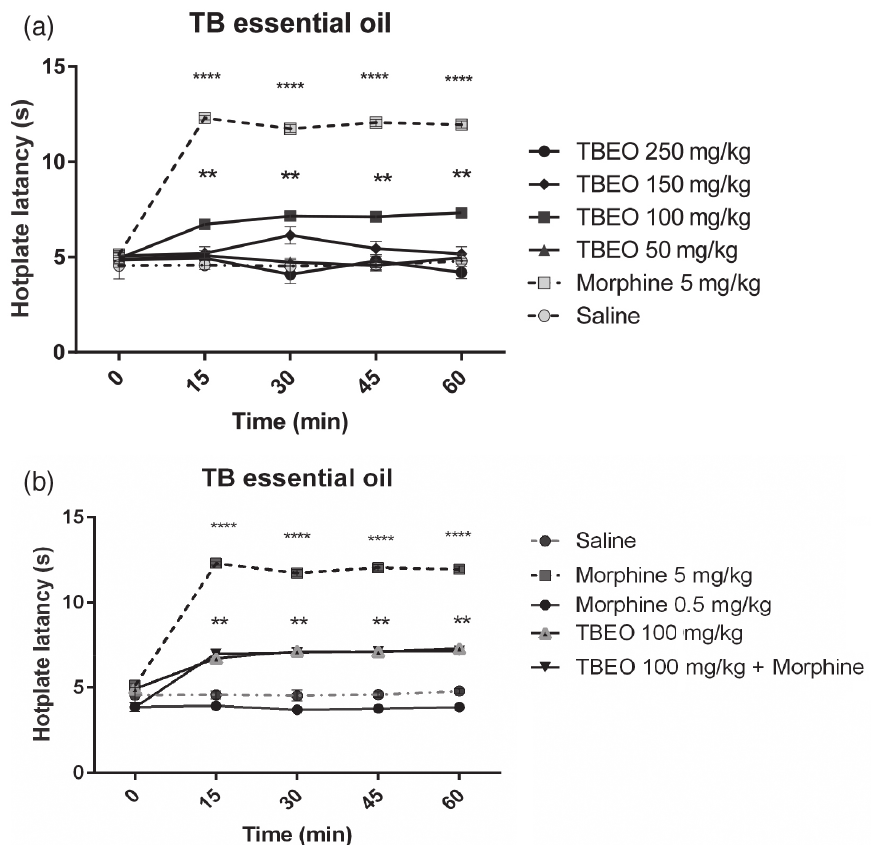
FIGURE 1 - Anti-nociceptive activity of TBEO in the Hot Plate Test. Data represent Mean ± SEM of six to eight animals in each group **P<0.01. ****P < 0.0001, compared with the control